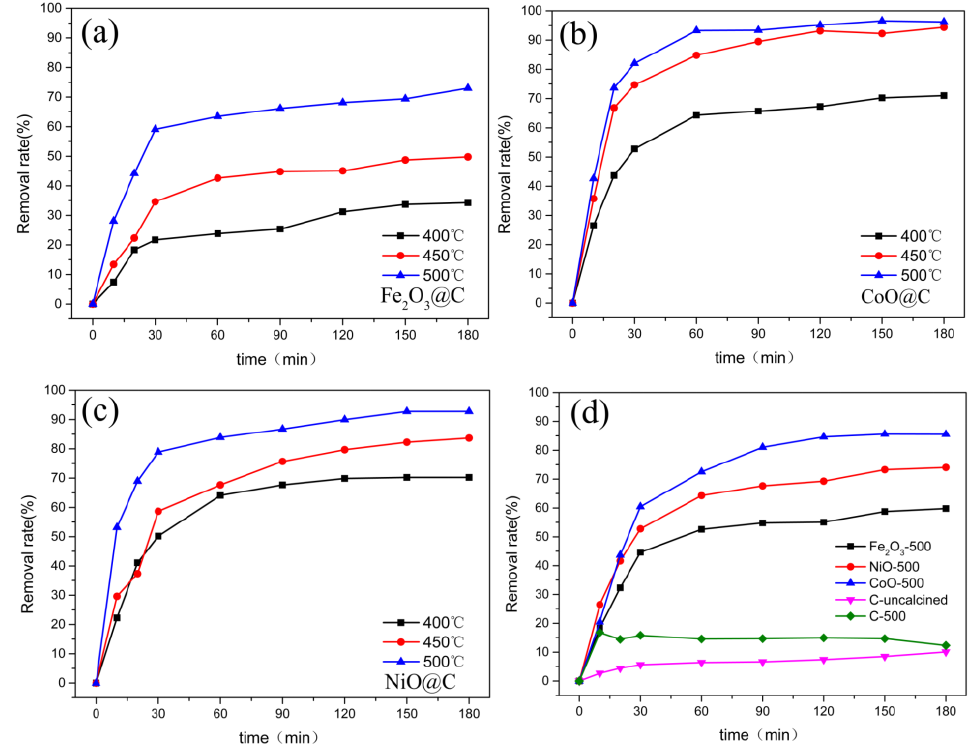
Figure 4. Removal efficiency of MO in the adsorption process on Fe 2 O 3 @C ( a ), CoO@C ( b ), NiO@C ( c ), pure metal oxides, and pollen carbon ( d ).